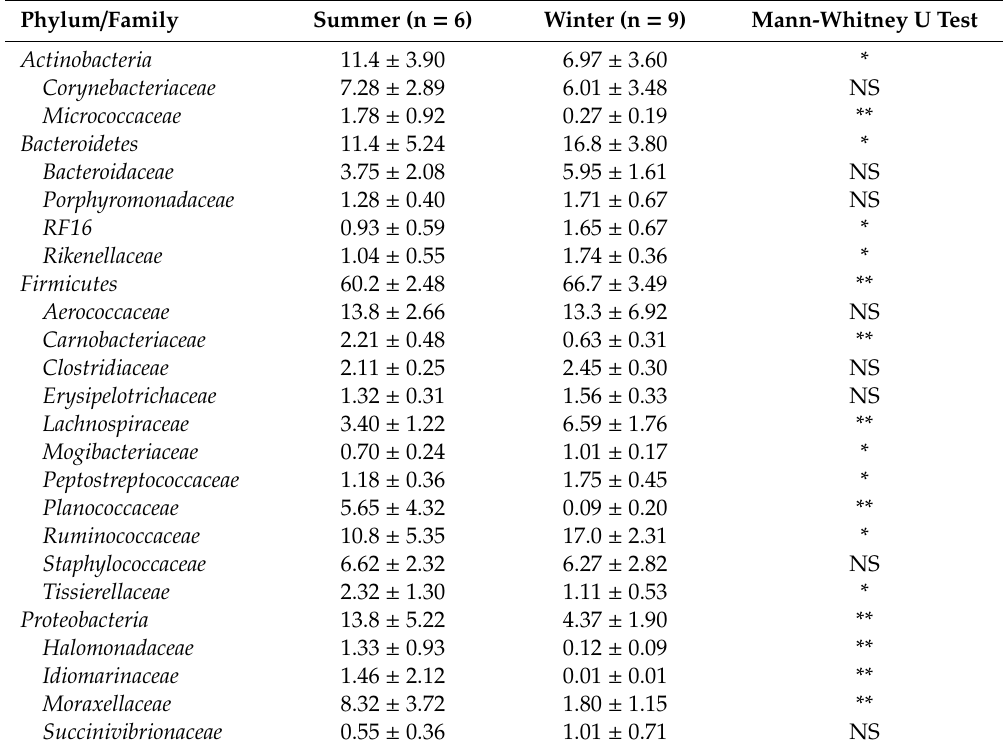
Table 4. Relative abundance (%) of bedding microbiota of the dairy farm cowshed examined at two